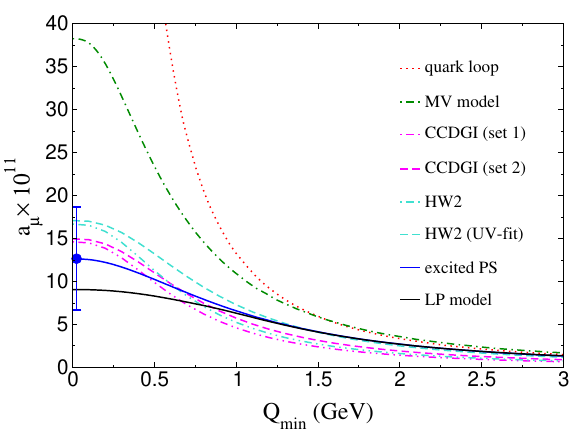
Figure 2. Comparison of the longitudinal short-distance contributions as a function of a common lower cuto ↵ Q min on the virtualities in the HLbL loop integral. The red dashed line refers to the perturbative QCD quark loop, the others to Ref. [19] (MV), Ref. [71] (CCDGI), Ref. [70] (HW2), Refs. [30, 31] (excited PS), and Ref. [74] (LP); from Ref.